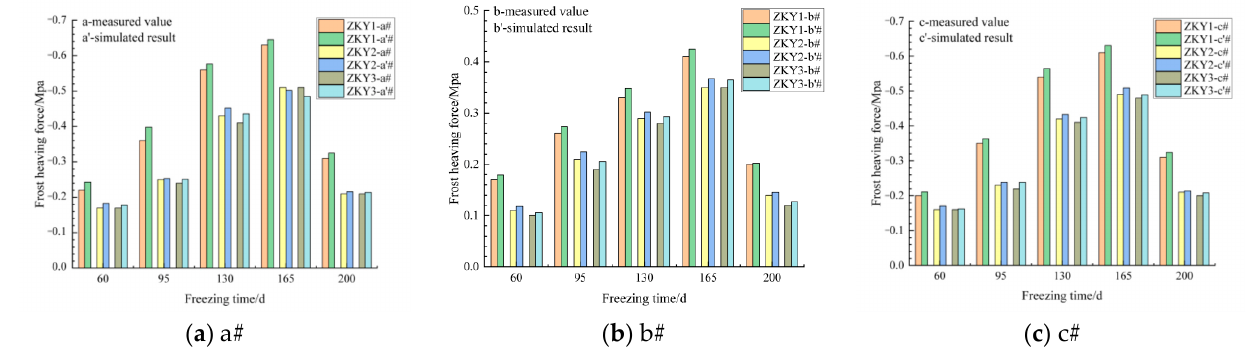
Figure 6. Comparison and verification of measured values and finite element simulated values of frost heaving force (unit: MPa).